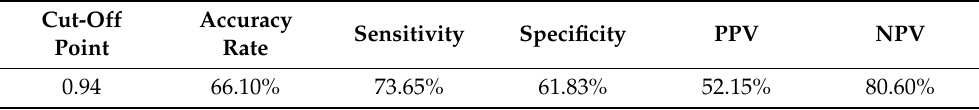
Table 3. Optimal cut-off value for SI with corresponding accuracy, sensitivity, and specificity. Cut-Off Accuracy Sensitivity Specificity PPV NPV Point Rate 73.65% 52.15%